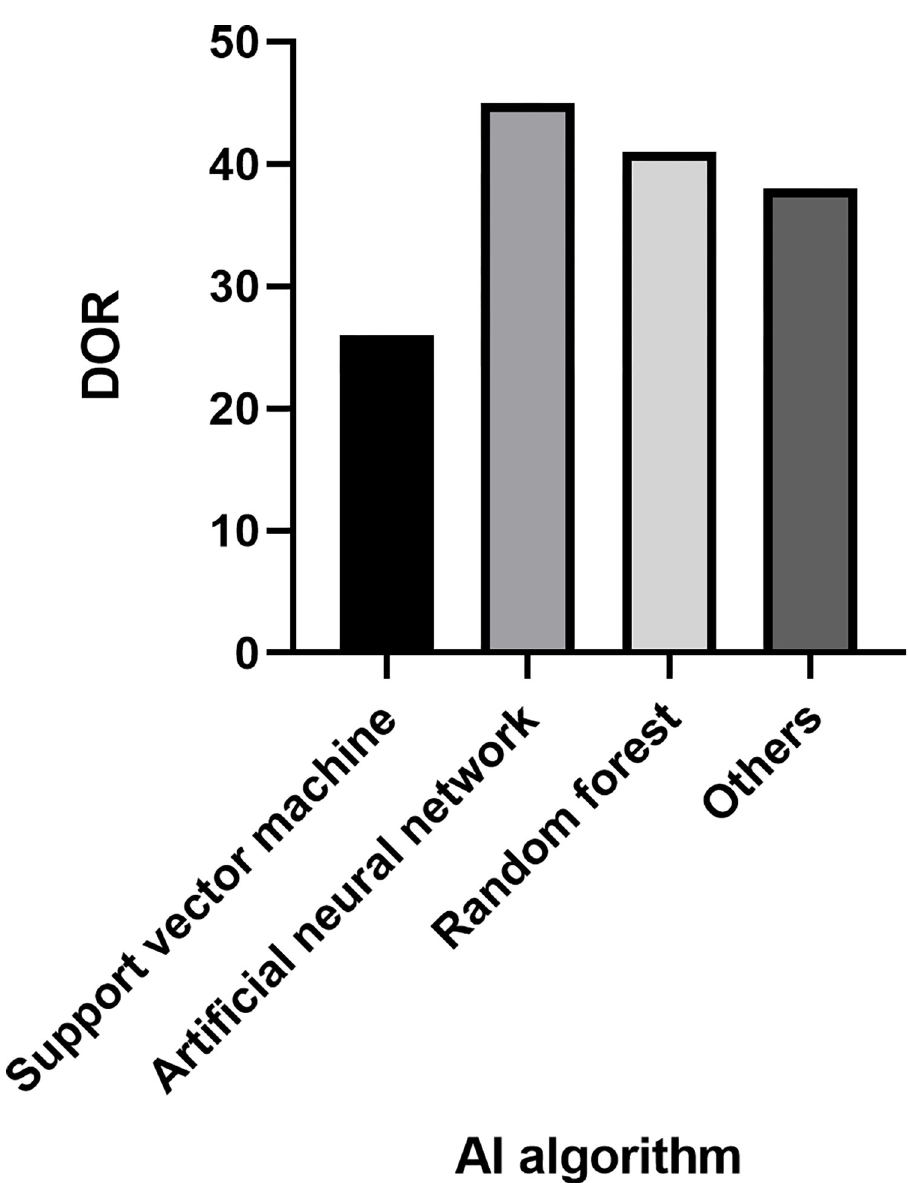
Fig 7. Results of the subgroup analysis of lung cancer diagnosed with the aid of artificial lung cancer diagnosis.